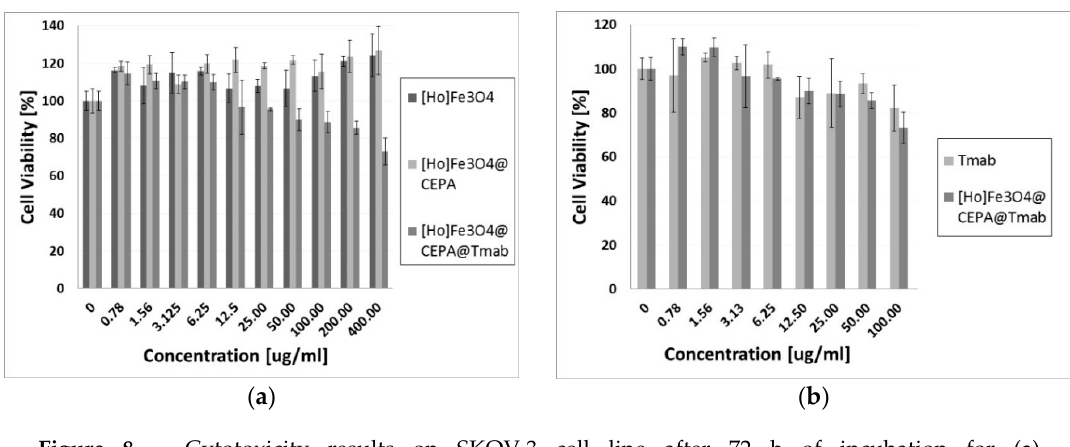
Figure 8. Cytotoxicity results on SKOV-3 cell line after 72 h of incubation for ( a ) Ho-SPION, Ho- SPION@CEPA, Ho-SPION@CEPA@Tmab; and ( b ) Tmab in comparison to